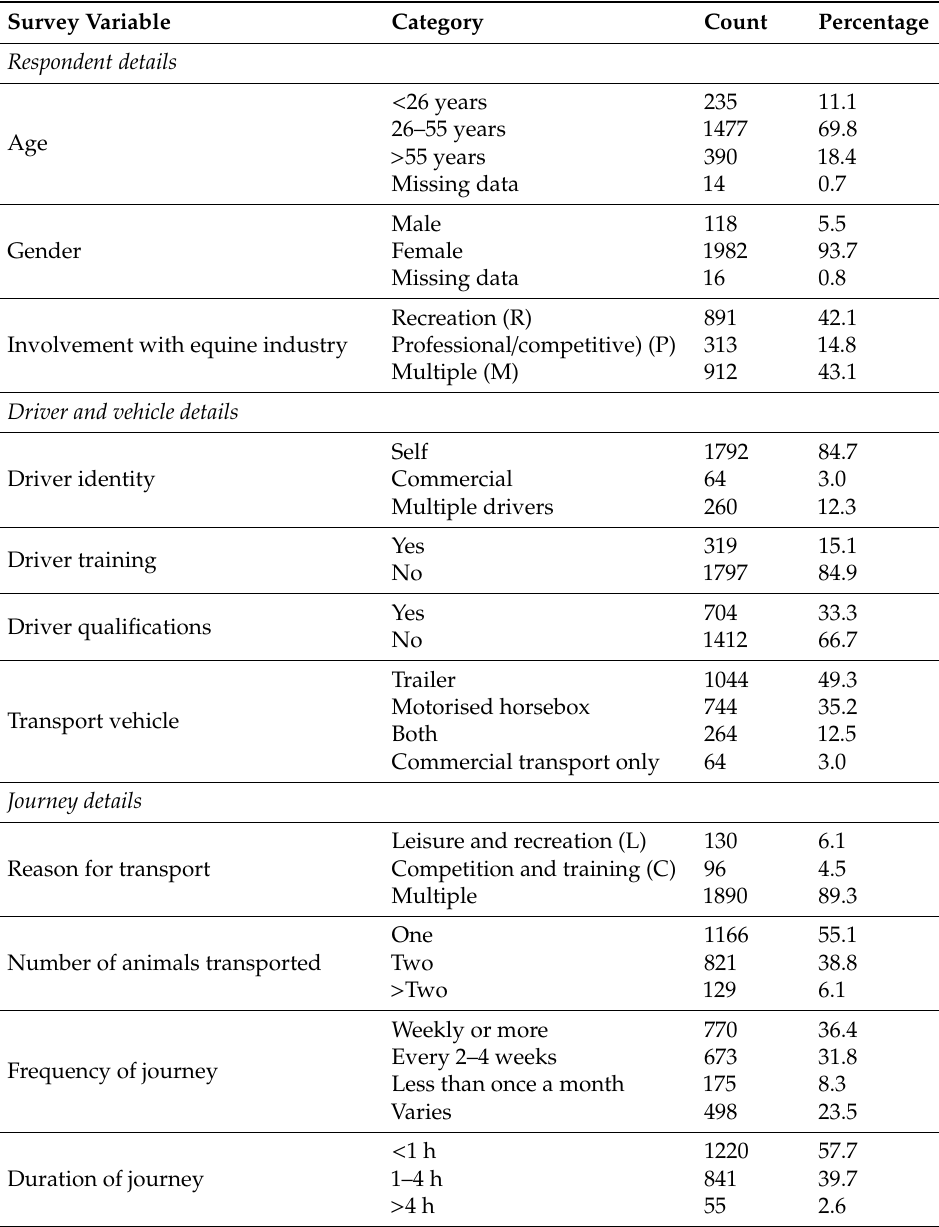
Table 3. Frequency table for demographic and transport characteristics of survey population (count and